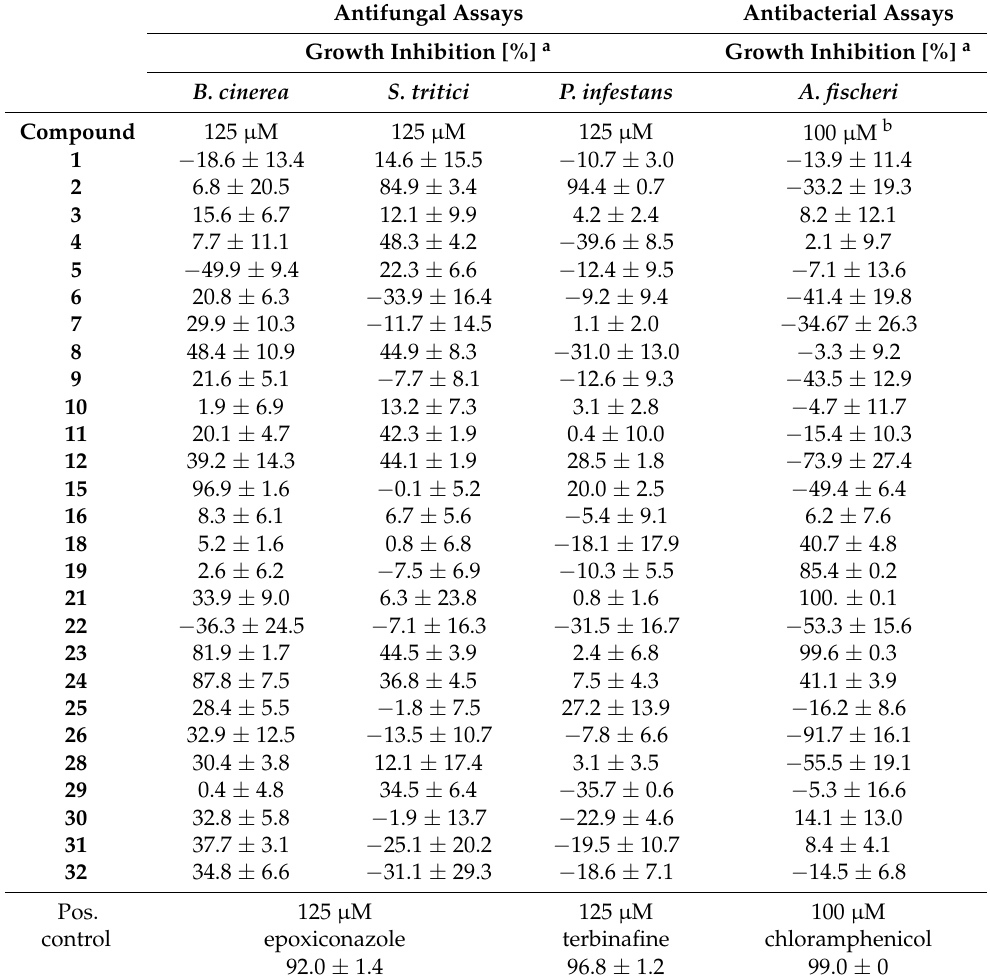
Table 4. Antifungal ( Botrytis cinerea, Septoria tritici ), antioomycotic ( Phytophthora infestans ), and antibacterial ( Aliivibrio fischeri ) activities of isolated compounds from P. sarmentosum